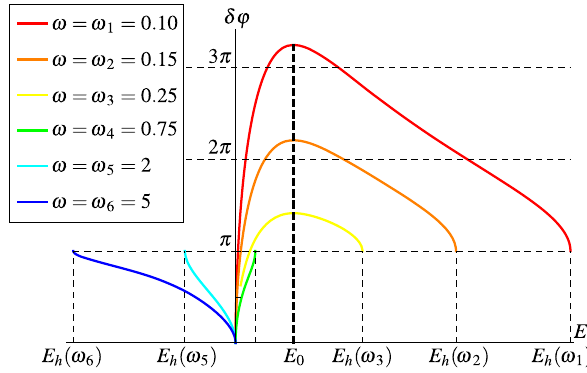
Fig. 11 The dependence of δϕ on the integration constant E along various constant ω curves in the parameter